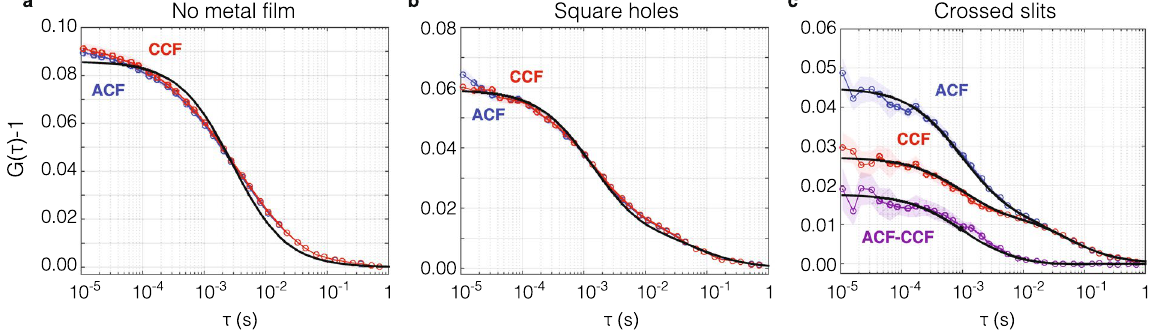
Figure 5. Experimental intensity correlations for nano-aperture 2fFCS. Intensity correlations for ( a) . A lipid bilayer directly on glass, ( b ). A polarization insensitive square hole array in gold, and ( c ). The crossed slits. Blue curves with circular symbols correspond to autocorrelations, i.e., correlating detectors in the same polarization channel, while red curves with square symbols correspond to cross-correlation of polarization channels. For the reference system ( a ) and the polarization insensitive antennas ( b ), the auto- and crosscorrelates are identical, but a strong difference appears for the crossed nanoslit sample ( c ). Shaded areas around the curve indicate the standard error in the mean, given that curves are averages over 3 runs of 120 seconds each, where we furthermore average over all auto- resp. crosscorrelating detector combinations. Dotted (dash-dotted) black lines indicate the fitted ACF (CCF) according to a simple Gaussian model (see text). Note that for panels b,c the difference is the polarization cross-talk required to fit the data. In ( b ) all apertures contribute equally independent of polarization leading to an identical auto- and crosscorrelation. In ( c ) the x ( y )-oriented holes contribute 4 times more strongly to MDF y ( x ) than the y ( x )-oriented holes. In panel c the purple curve shows the difference in correlations, corresponding to the temporal correlation of instantaneous polarization differences. The black curve superimposed on the purple curve is the difference of the fits to the CCF and ACF, which has a rolloff time of 0.93 ms. Diffusion at the aperture substrate is slowed down compared to the reference case ( D = 0.33 versus 4.5 μ m 2